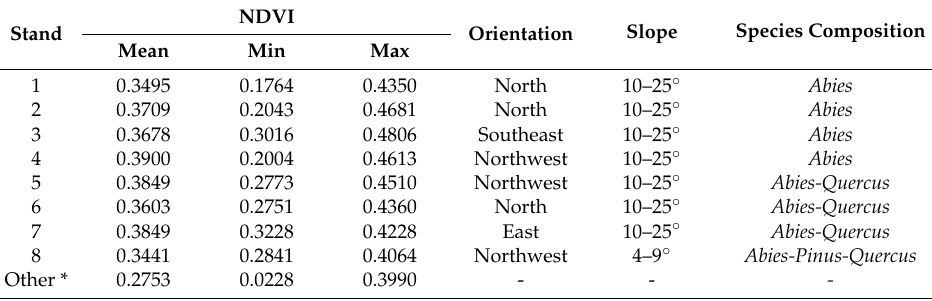
Table 1. Criteria and values used for forest zoning.